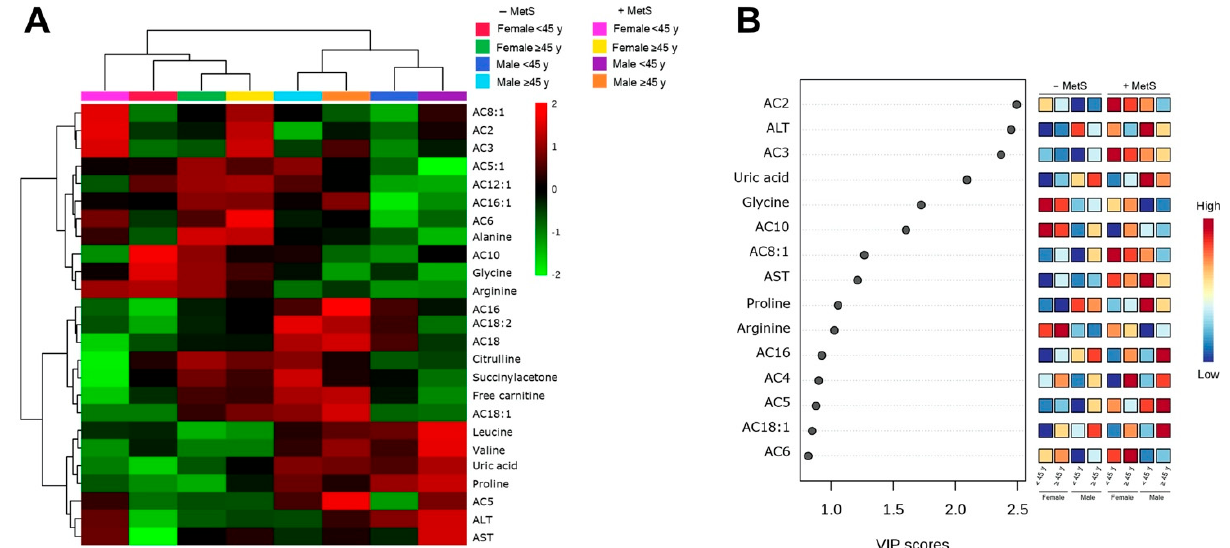
Figure 5. Serum metabolite profile according to MetS, sex, and age. ( A ) Hierarchical heatmap for MetS diagnosis, sex, and age: Females: − MetS: <45 years (red) and ≥ 45 years (green); +MetS: <45 years (pink) and ≥ 45 years (yellow). Males: − MetS: <45 years (dark blue) and ≥ 45 years (light blue); +MetS: <45 years (purple) and ≥ 45 years (orange). The explained variances are shown in brackets (accuracy 0.375; R2 0.133; Q2 0.081: permutation p value < 5.0). ( B ) VIP analysis represents the relative contribution of metabolites to the variance among groups. A high VIP score indicates a greater contribution of the metabolites to the group separation. Red and blue boxes indicate whether metabolite concentration is increased (red) or decreased (blue). − Mets (without MetS), +MetS (with MetS).